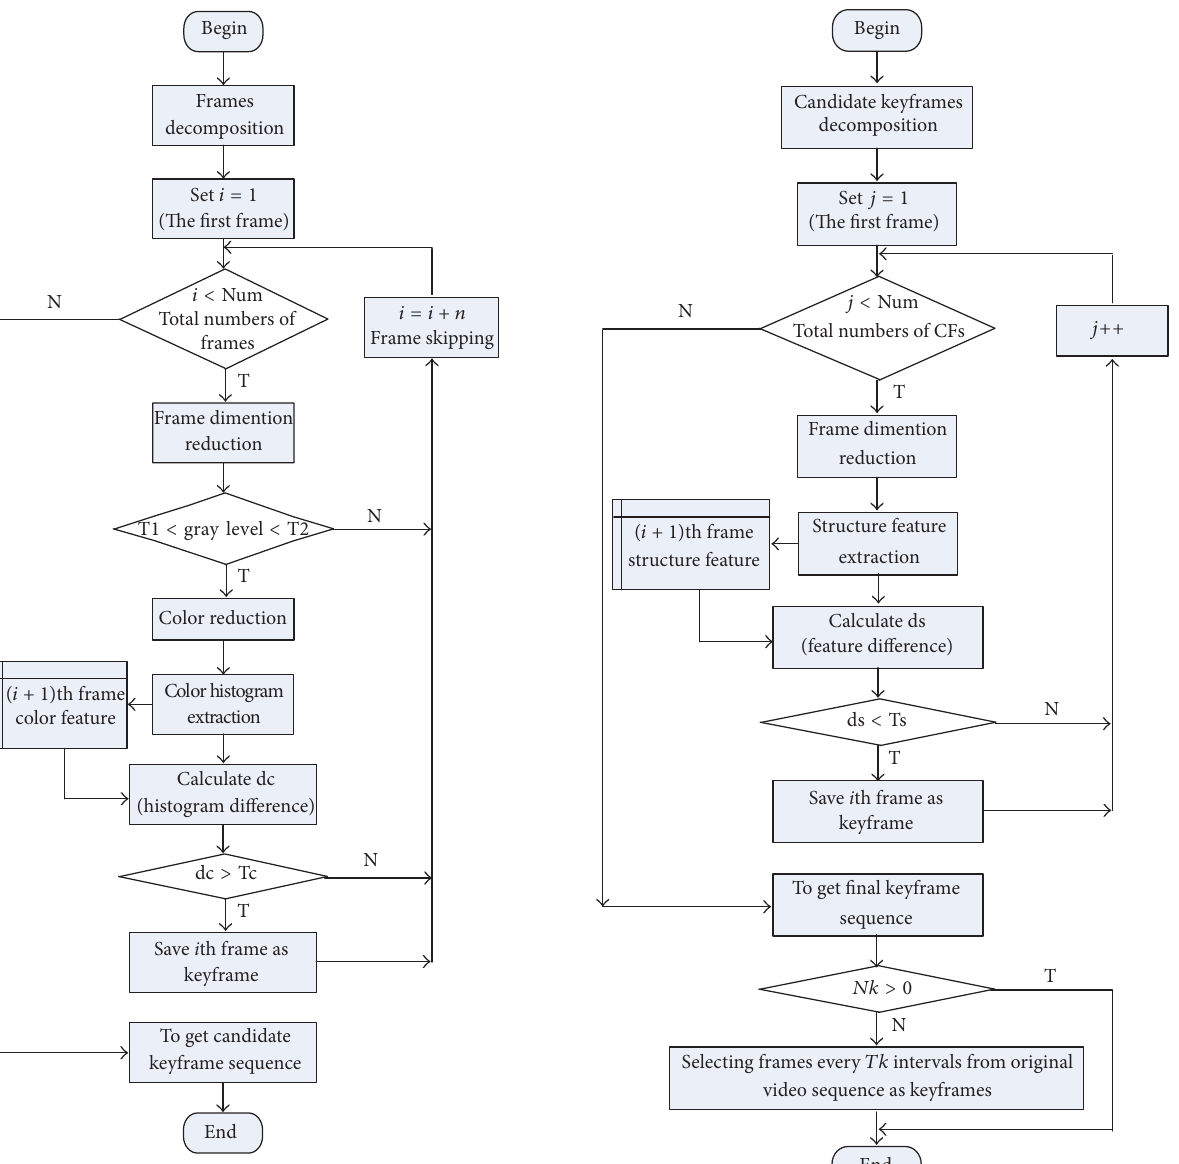
Figure 4: Flowchart of generating candidate key frame sequence. alternative key frame structure similarity between adjacent frames is determined to further reduce key frames.